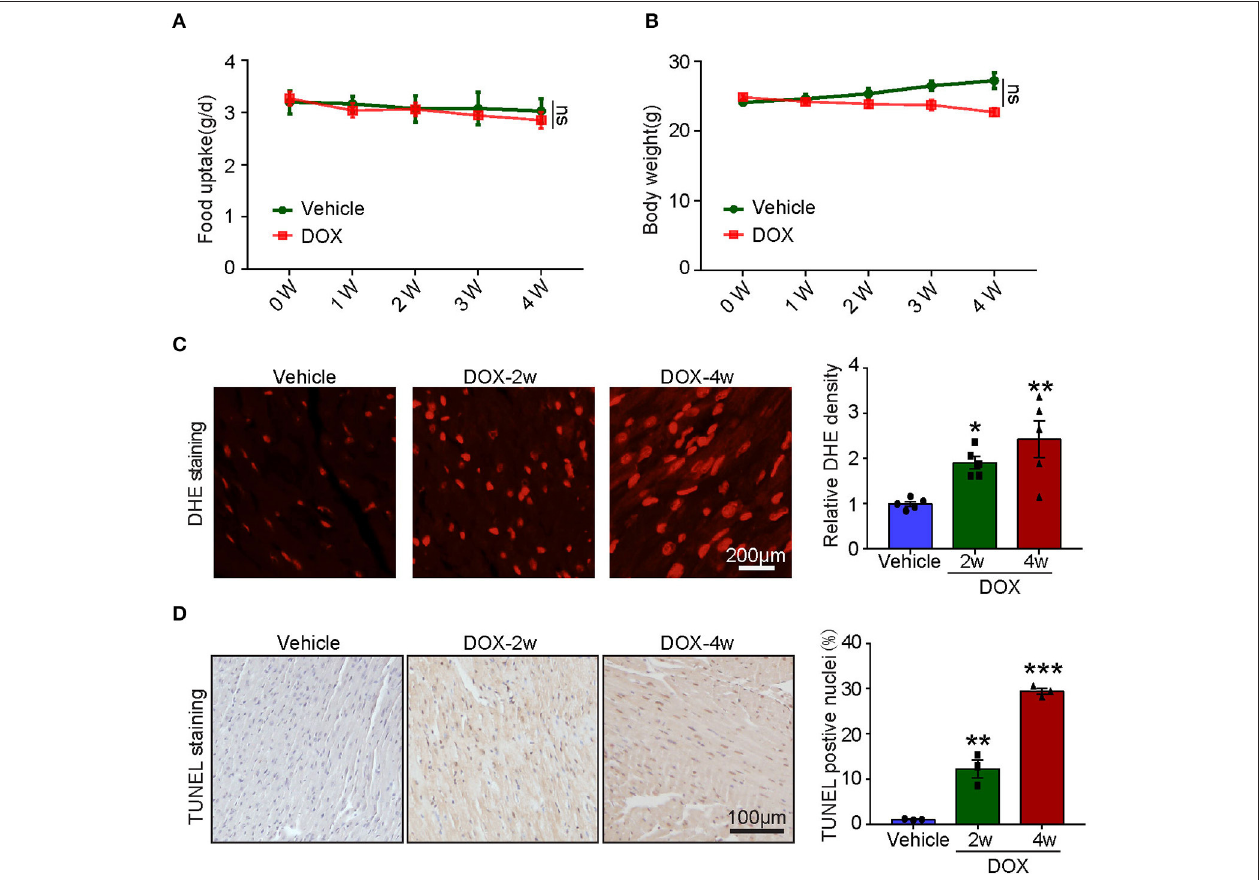
FIGURE 2 | Doxorubicin dose-dependently induced cardiac oxidative stress and apoptosis. Mice were intravenously treated with DOX (5 mg/kg) or its solvent once per week for 2 or 4 weeks. (A,B) The changes of food uptake and body weight after DOX treatment ( n = 4). (C) Reactive oxygen species (ROS) generation was measured by dihydroethidium (DHE) staining, and the quantification of fluorescence intensity was shown right ( n = 5). Scale bar 200 µ m. (D) Representative TUNEL staining in the heart tissues and the TUNEL-positive nuclei were quantified ( n = 3, right). Scale bar 100 µ m. * p < 0.05, ** p < 0.01, *** p < 0.001 vs. vehicle.